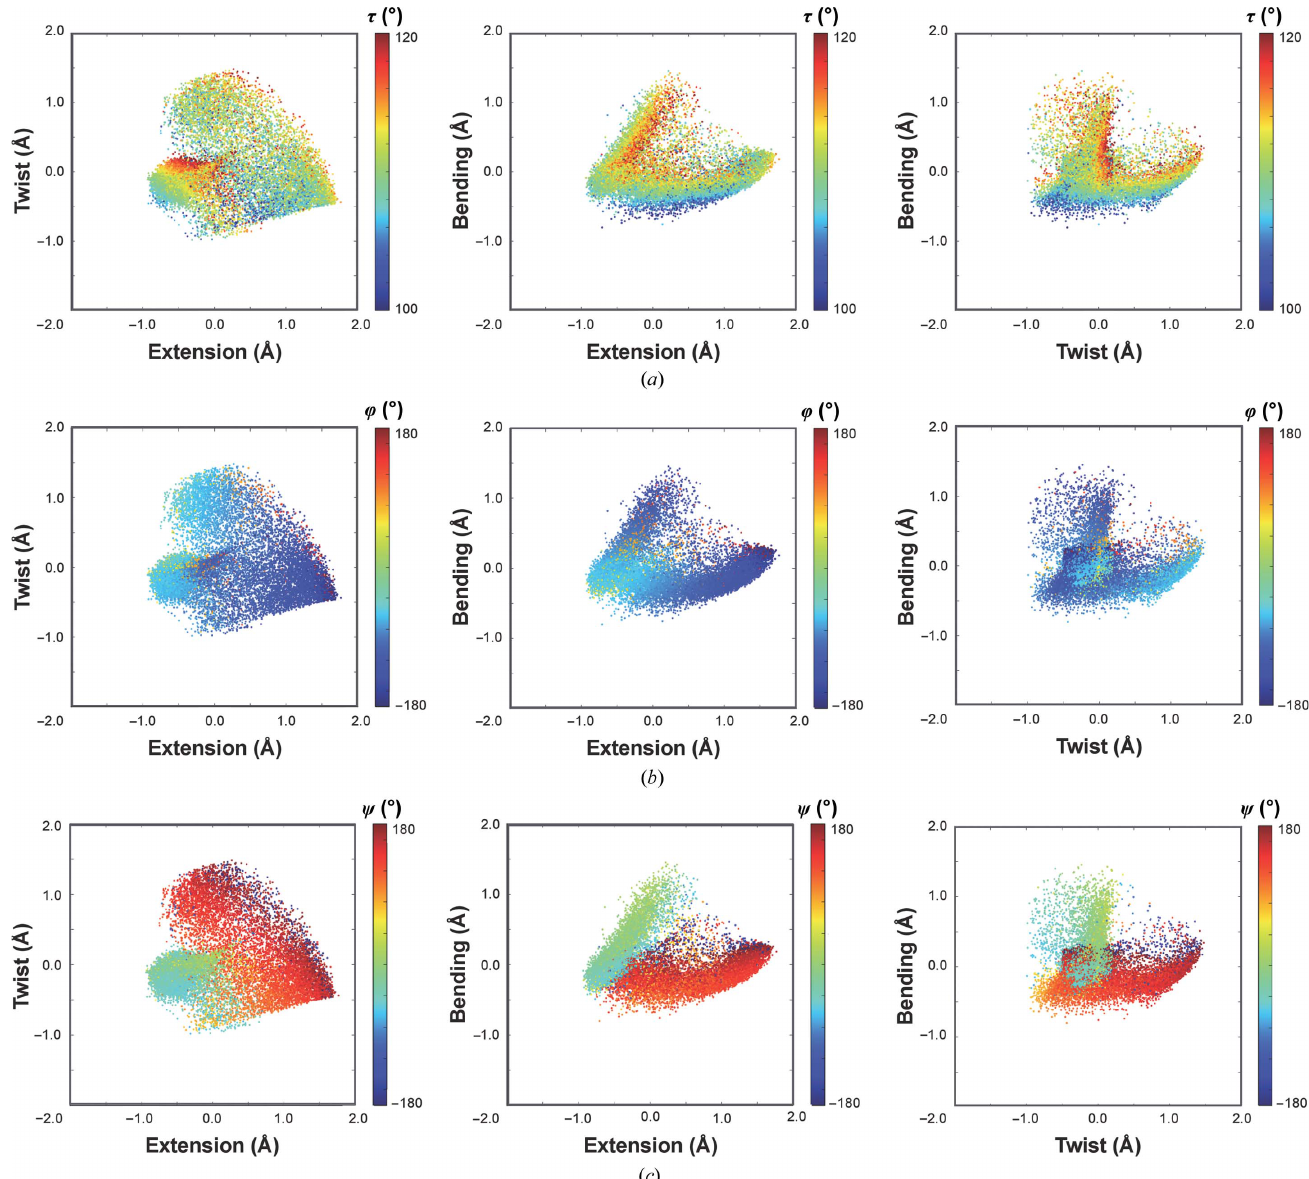
Figure 4 The DipSpace coloured according to ( a ) the (cid:3) stretching angle, ( b ) the Ramachandran ’ dihedral angle and ( c ) the Ramachandran dihedral